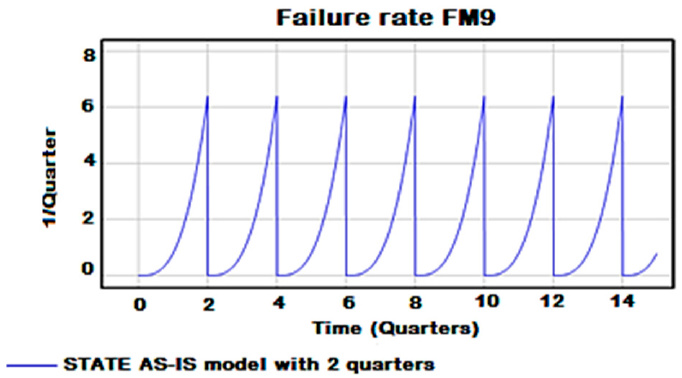
Figure 7. AS-IS FM9 Guide misalignment.